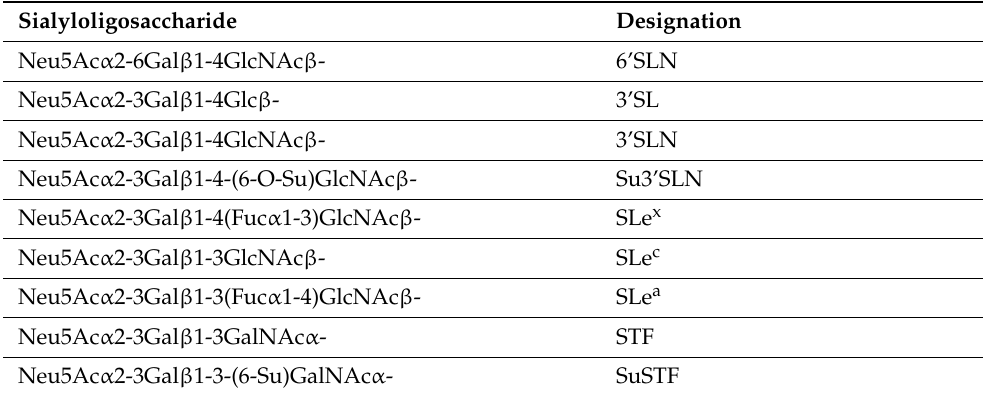
Table 4. Sialyloligosaccharide and designation of the oligosaccharide moieties.